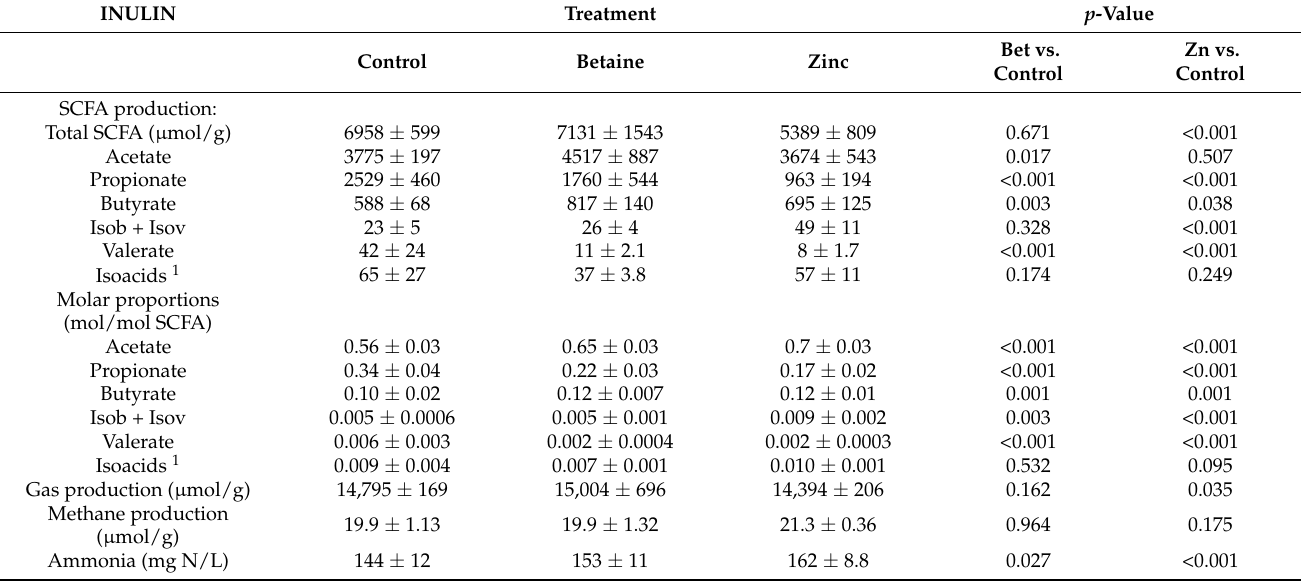
Table 3. Production of SCFA, molar proportions of SCFA, gas and methane production, and ammonia concentration after 24 h of the in vitro fermentation of inulin by fecal inocula obtained from pigs under heat stress conditions and fed diets supplemented or not with betaine (5 g/kg) or zinc (0.120 g/kg). Means ± standard deviations are shown.